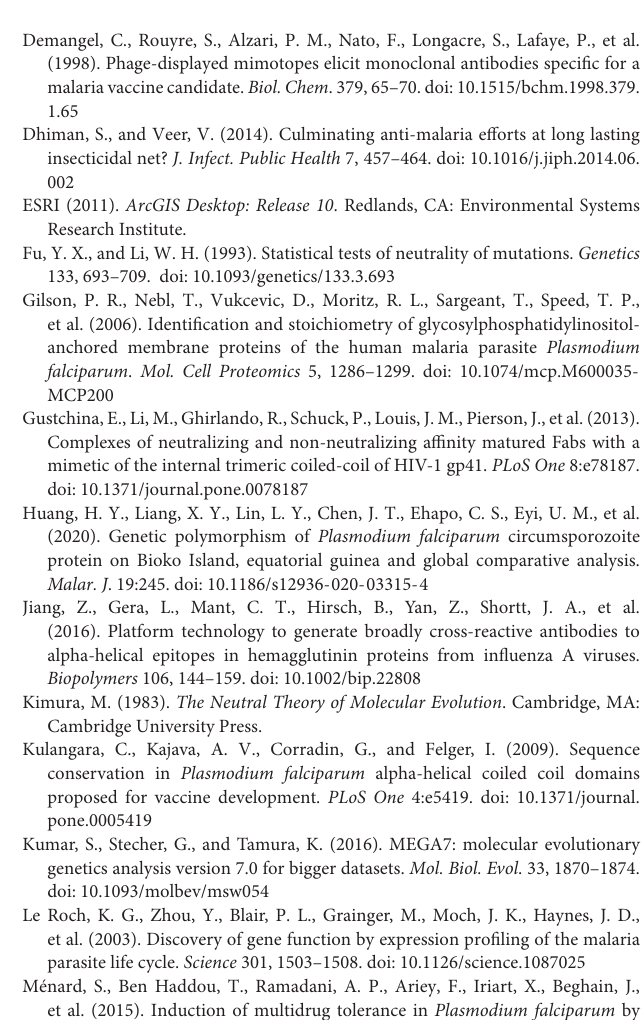
bootstrap values. Supplementary Table 1 | Country of origin and parasitemia of P. falciparum samples. Supplementary Table 2 | Neutrality tests of pfsra among 74 P. falciparum isolates. Supplementary Table 3 | The sra Gene ID number and gene length of other Plasmodium